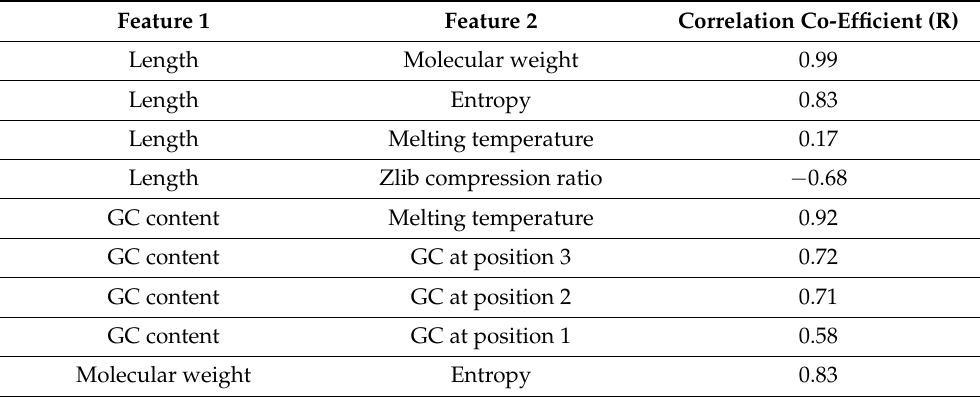
Table 2. Pearson correlation test for nucleotide features with p -value <